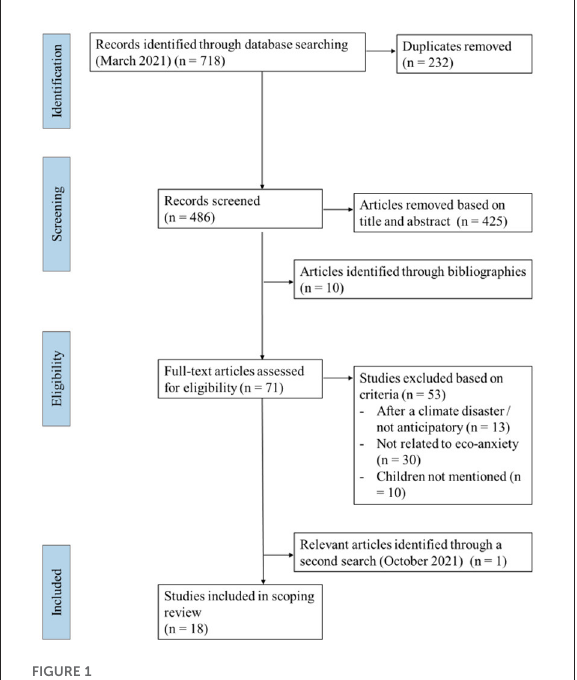
FIGURE1 Preferred reporting items for systematic reviews and meta-analyses extension for scoping reviews (Prisma-ScR) flow